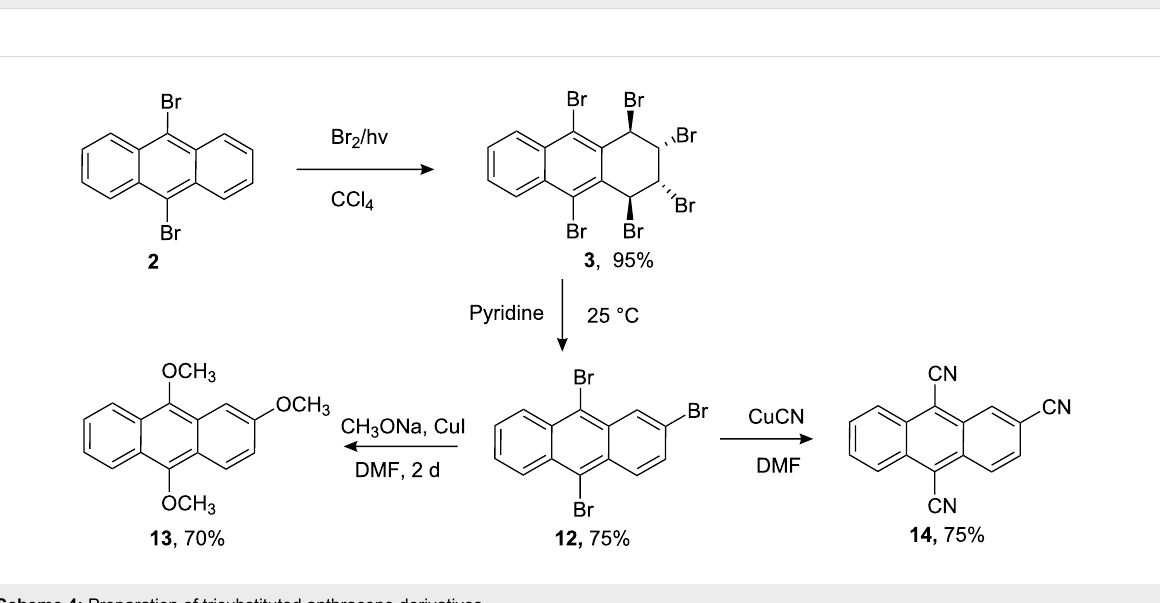
Scheme 4: Preparation of trisubstituted anthracene derivatives.